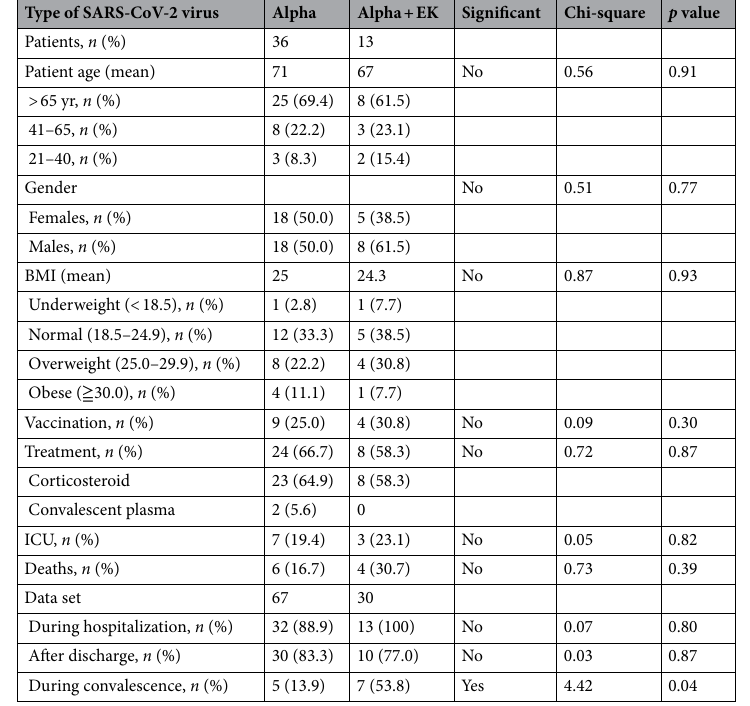
Table 1. Demographic and Clinical Characteristics of COVID-19 patients infected by the Alpha or Alpha+E484K SARS-CoV-2